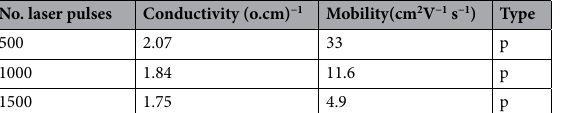
No. laser pulses